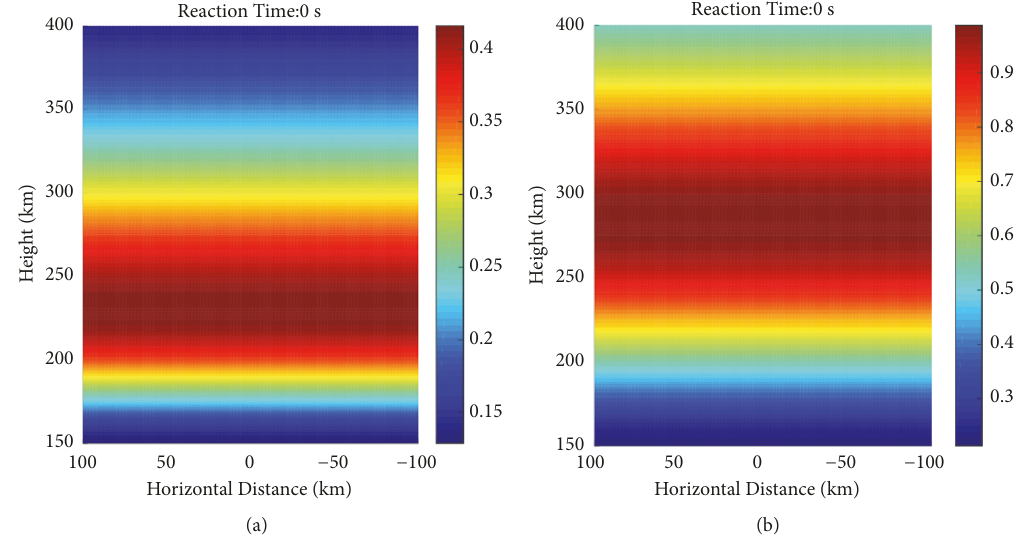
Figure 7: (a) Background ionospheric electron concentration profile in Yinchuan; (b) background ionospheric electron concentration profile in Haikou.